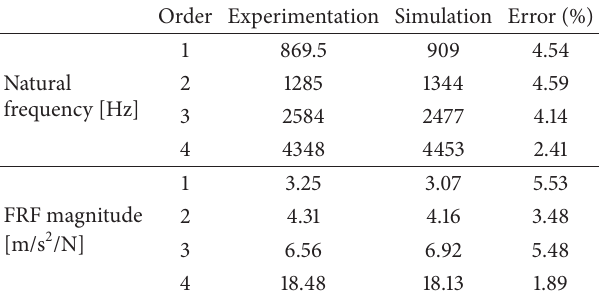
Table 2: Natural frequency and FRF magnitude